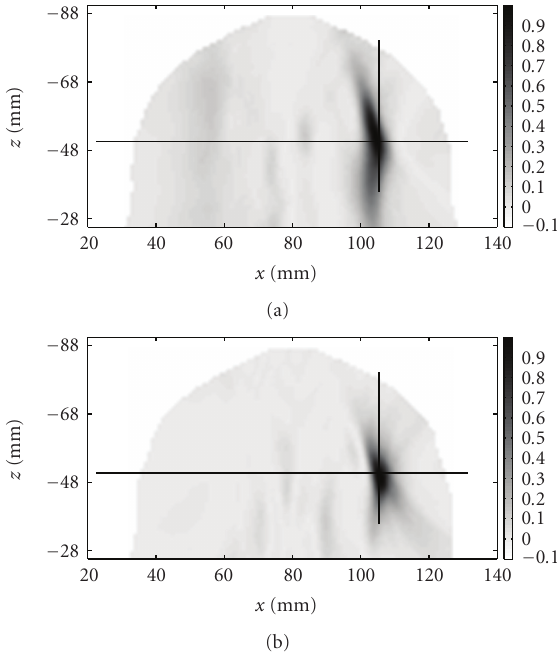
Figure 15: Comparison of focused tumor response between the BAVA (a) and BAVA-D (b) with 2 additional rows of data compared to Figure 13. The intersection of the thin lines indicates the location of the center of the inclusion. Each image is normalized to the specific dataset.